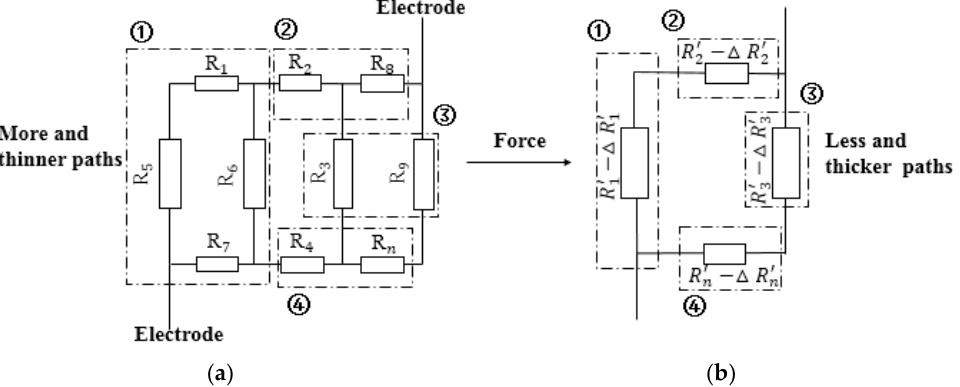
Figure 4. Equivalent circuit diagrams of resistance change of polymer-based flexible sensor. ( a ) Initial state. ( b )Pressed state.